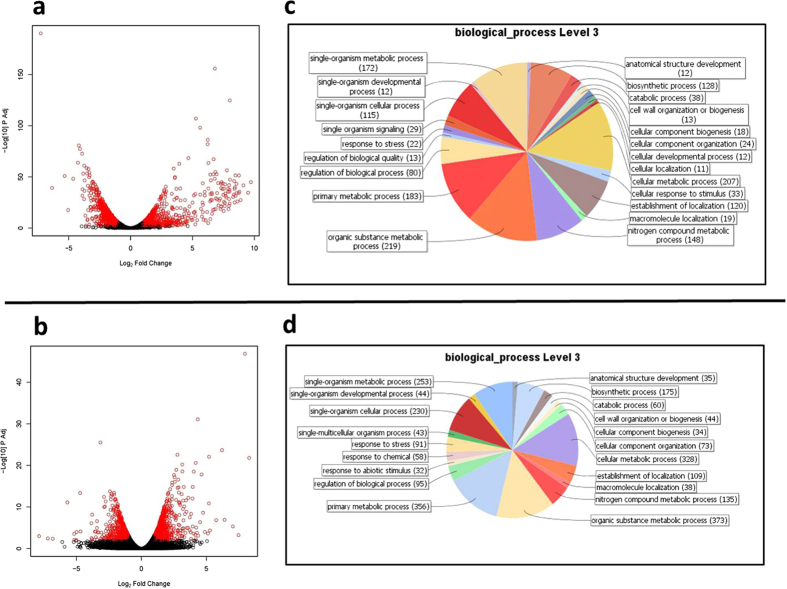
Results of the “dual transcriptome analyses”.(a) Volcano scatter plot of fold change (log2) Vs DESeq adjusted P-values (−log10) of Burkholderia vs Burkholderia colonized sugarcane roots (a) or of sugarcane vs sugarcane colonized by Burkholderia (b). Red circles represent adjusted P values < 0.01 and >2 fold change. Level 3 Gene Ontology (GO) terms distribution of 1,628 unigenes induced in Burkholderia colonized on sugarcane roots (c) or of 2,606 unigenes induced in sugarcane roots colonized by Burkholderia (d).